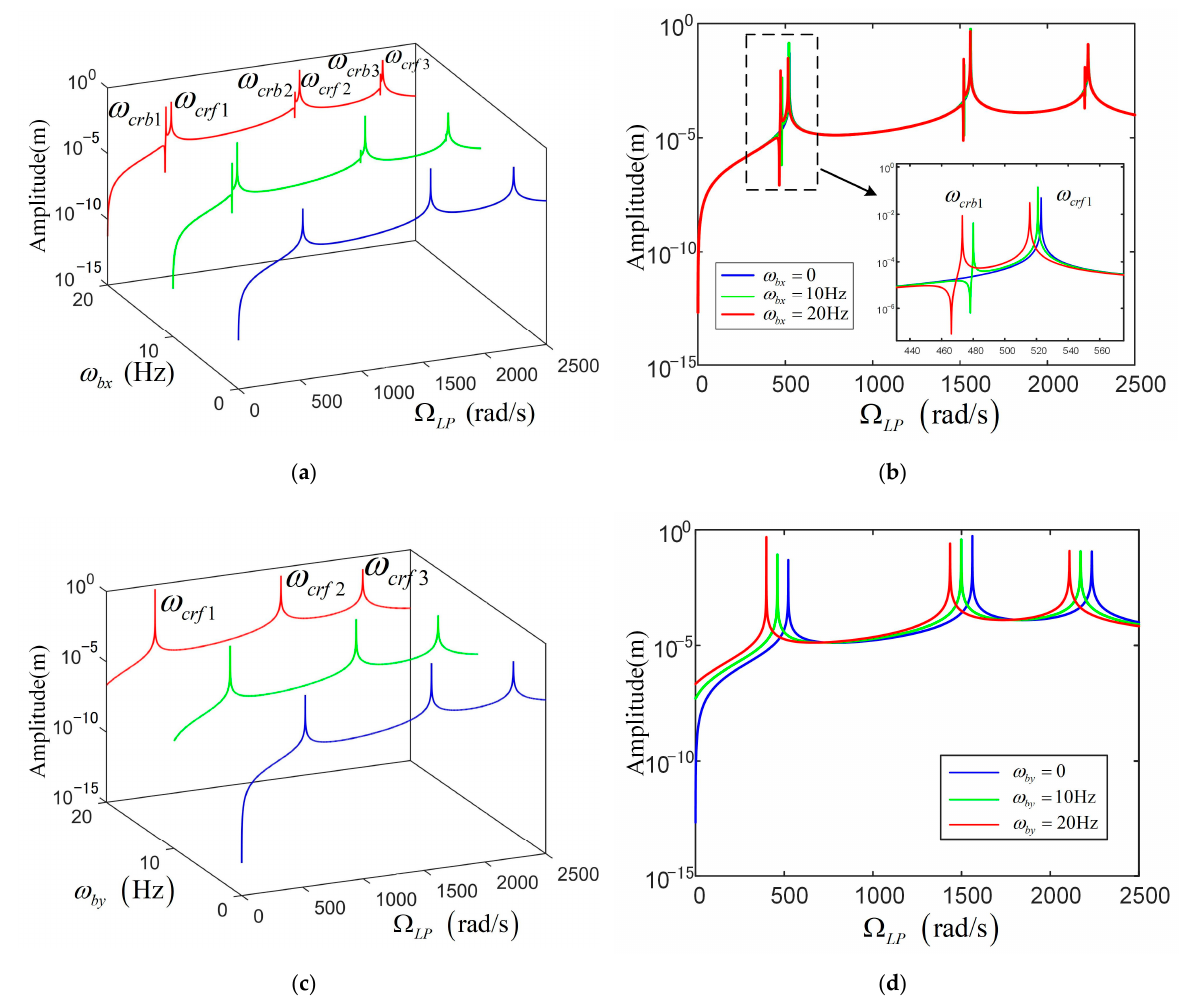
Figure 6. Responses of the dual rotor system excited by mass unbalance on disk 2 with base motions: ( a ) Pitching base motion; ( b ) Pitching base motion; ( c ) Rolling base motion; ( d ) Rolling base motion. For the mass unbalance on a high-pressure rotor, the mass unbalances are set at 𝑚 (cid:3048)(cid:2869) 𝑒 (cid:2869) = 𝑚 (cid:3048)(cid:2870) 𝑒 (cid:2870) = 0 and 𝑚 (cid:3048)(cid:2871) 𝑒 (cid:2871) = 1 × 10 (cid:2879)(cid:2872) kg ⋅ m . The frequency responses are shown in Figure 7. Only the backward whirling modes were excited when the base was fixed (see the blue lines). For the pitching base motion shown in Figure 7a,b, the forward whirling modes were also excited when the pitching base motion was concerned. The resonant fre- quencies decreased a little with increasing angular velocity of the pitching base motion.